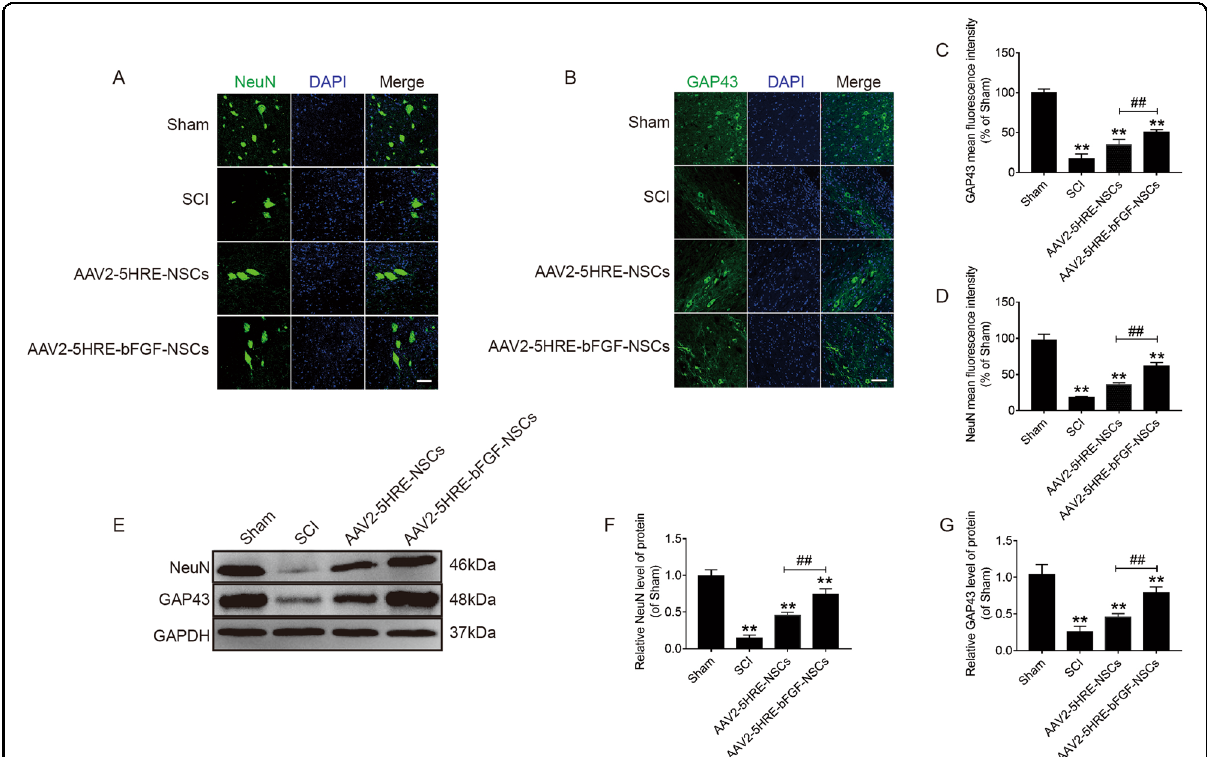
Fig. 5 AAV2-5HRE-bFGF-NSCs upregulate the expression of NeuN and GAP43. A Immuno fl uorescence staining of NeuN in sham group, SCI group, AAV2-5HRE-NSCs group and AAV2-5HRE-bFGF-NSCs group. The bright green dots are considered as positive staining of neurons. The nuclear is labeled by DAPI (blue). Scale bar = 50 µm. B Immuno fl uorescence staining of GAP43 in sham group, SCI group, AAV2-5HRE-NSCs group, and AAV2- 5HRE-bFGF-NSCs group. The label of nuclear is accomplished by DAPI (blue), the neurons with positive GAP43 signals are shown. Scale bar = 50 µm. C , D Quantitative analysis of NeuN and GAP43 fl uorescence intensity results. E – G Western blotting results of NeuN and GAP43 protein expression levels in sham group, SCI group, AAV2-5HRE-NSCs group, and AAV2-5HRE-bFGF-NSCs group. GAPDH was used as a reference. “ ** ” represents P < 0.01, versus the sham group or SCI group. “ ## ” represents P < 0.01, versus the AAV2-5HRE-NSCs group. Data are the mean values ± SEM ( n =